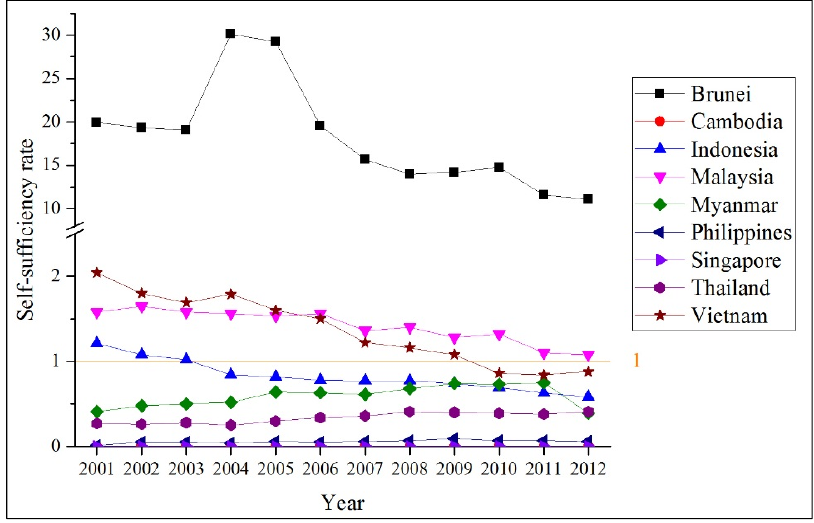
Figure 31. Crude oil self-sufficiency between 2001 and